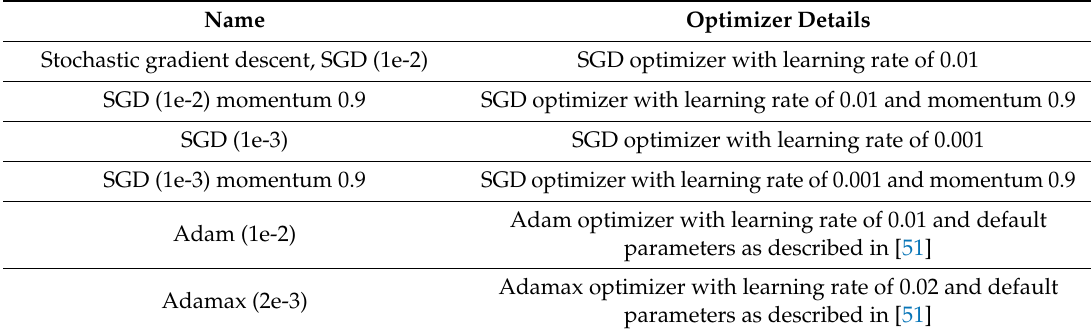
Table 5. Naming convention and optimizer details.